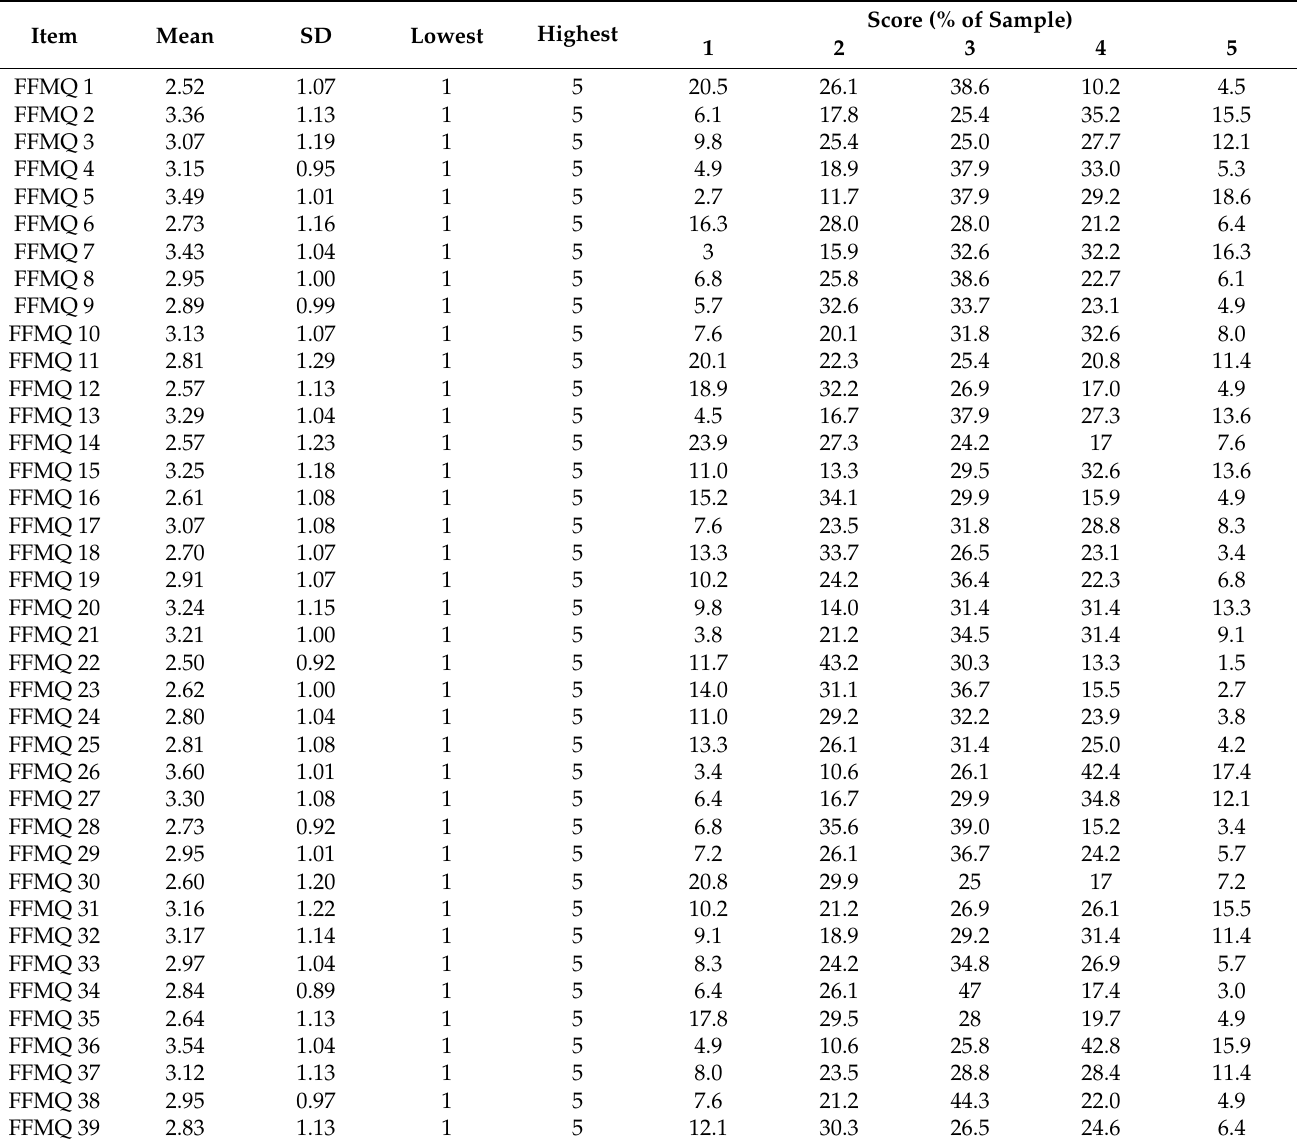
Table A3. Descriptive statistics of the Five Facet Mindfulness Questionnaire (FFMQ)